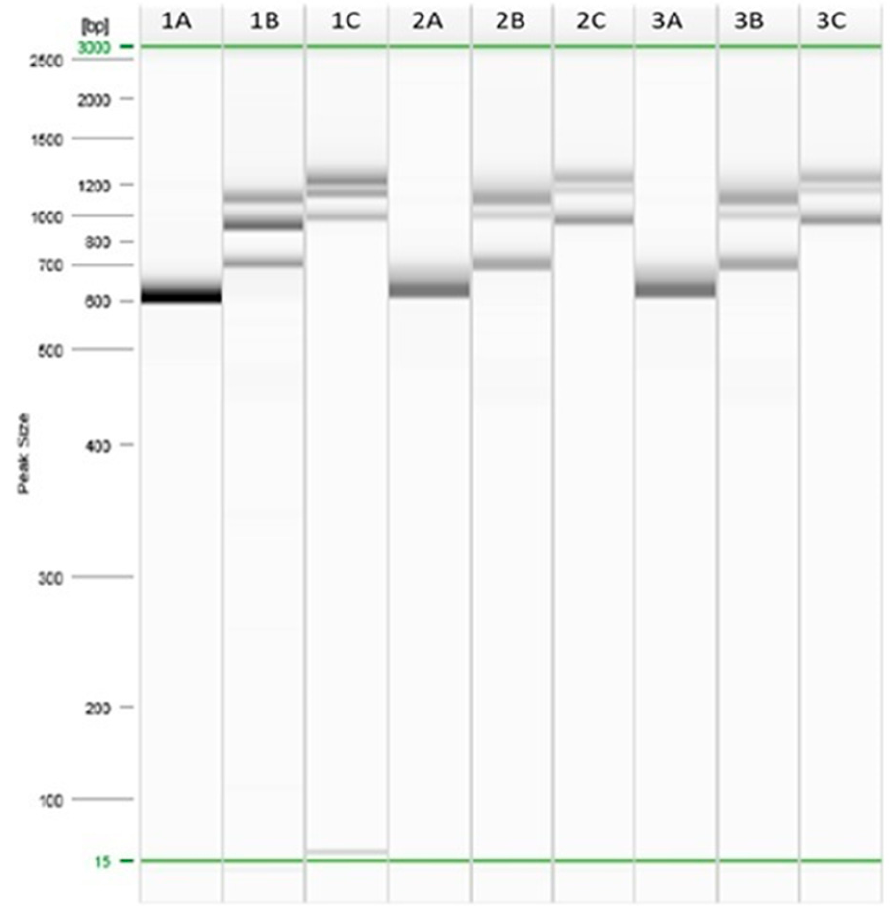
Figure 2. Multiplex PCR of Bacillus cereus in the following samples: (A) grain anise; (B) fenugreek and (C) instant noodles. The letter in each column indicates (A) cytK gene, (B) nhe genes and (C) hbl genes.